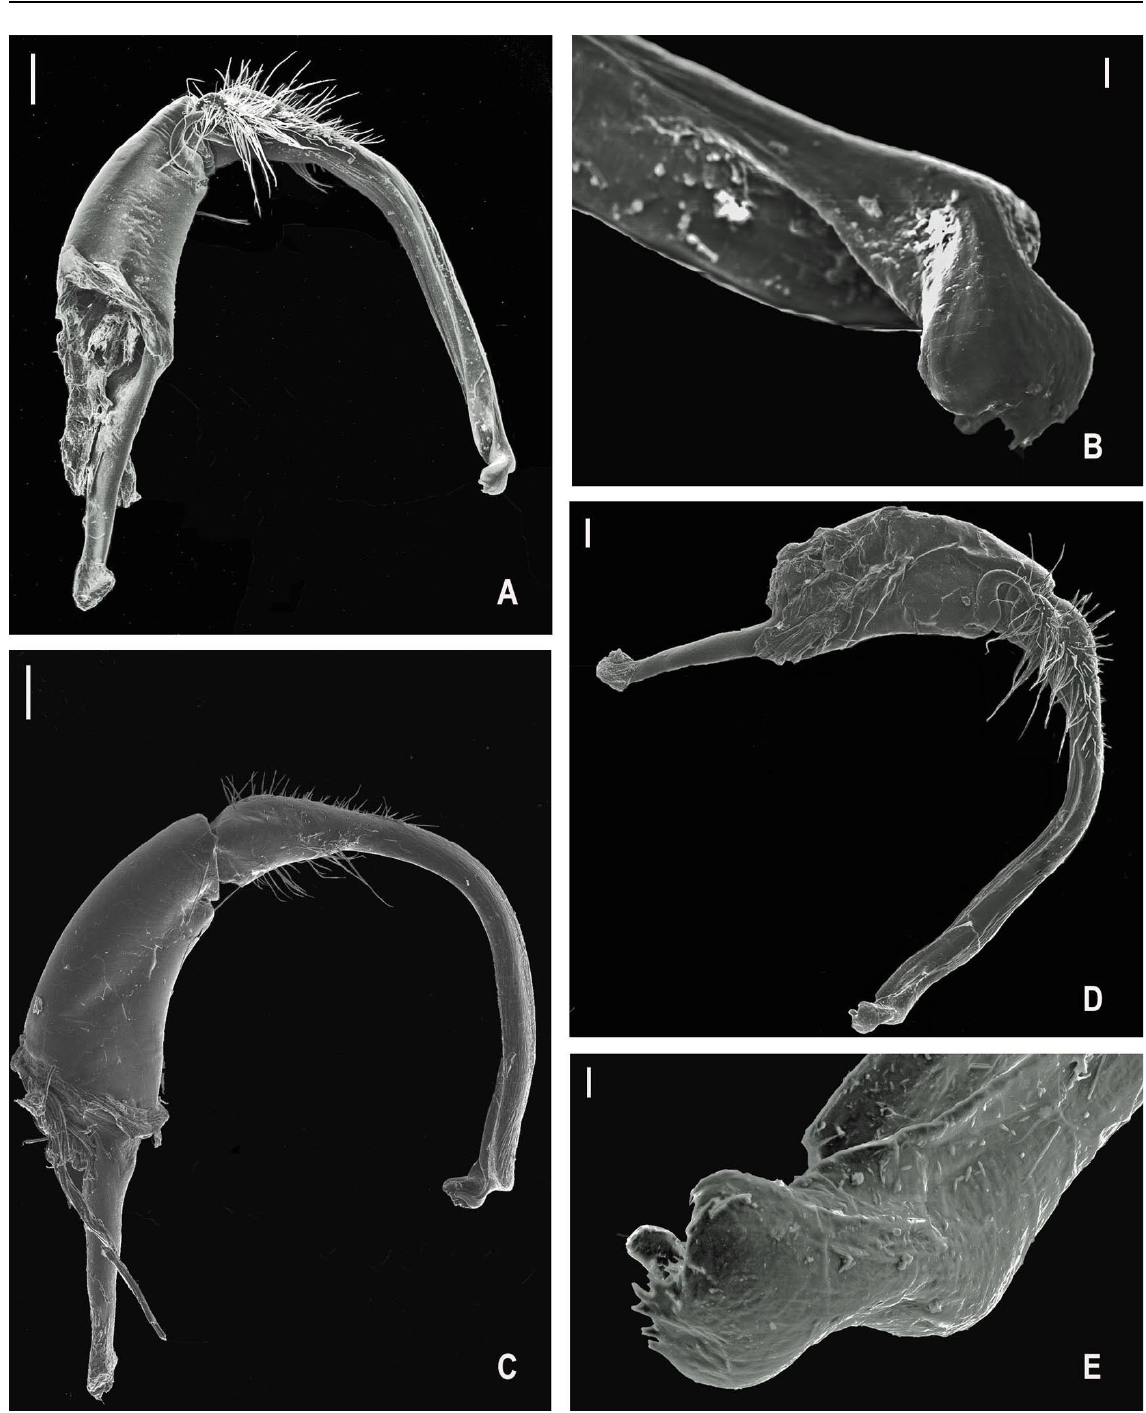
Fig. 7. Levizonus nakhodka Mikhaljova sp. nov., ♂♂, paratypes (FSCB 32020, 72020, 112020). A, D . Gonopod, mesal view. B, E . Gonopod apex, mesoventral view. C . Gonopod, lateral view. Scale bars: A, C = 200 μm; D = 100 μm; B, E = 20